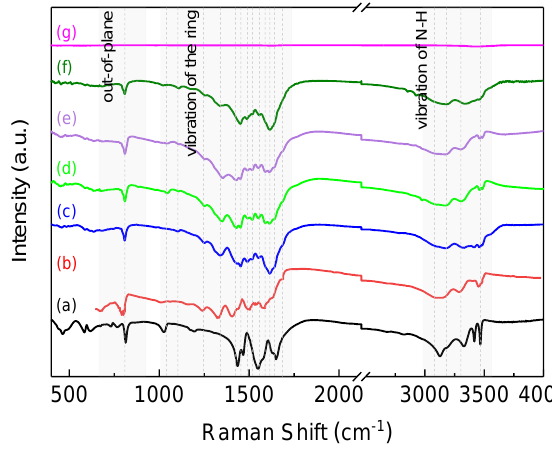
Figure 3. FTIR spectrum of melamine ( a ); melam ( b ); LTDP ( c ) and samples treated at 5 GPa and 400 °C ( d ); 500 °C ( e ); 600 °C ( f ); and 700 °C ( g ). Table 1. Vibrational frequencies (cm − 1 ) of melam, melamine, and LTDP